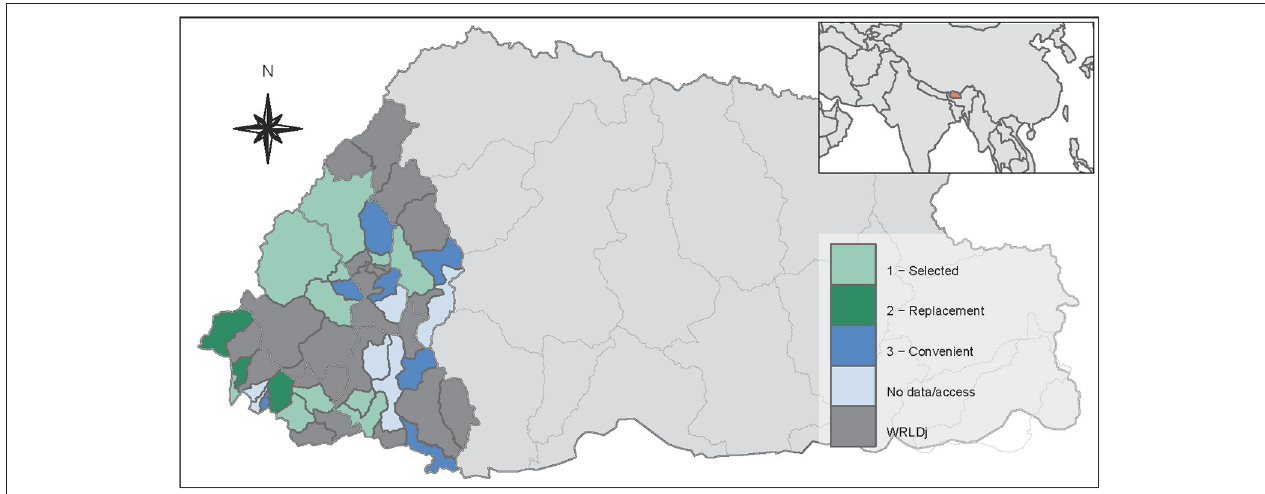
FIGURE 1 | West Regional Livestock Development jurisdiction (WRLDj) of Bhutan. A total of 23 animal health premises (AHP) located in 21 geogs were visited. Eleven AHP were selected and sampled (“selected”), three were chosen as adequate replacements (“replacement”), and another nine were conveniently visited and sampled (“convenient”). A total of 2,266 veterinary consultation records performed in 2017 were collected and scrutinised.